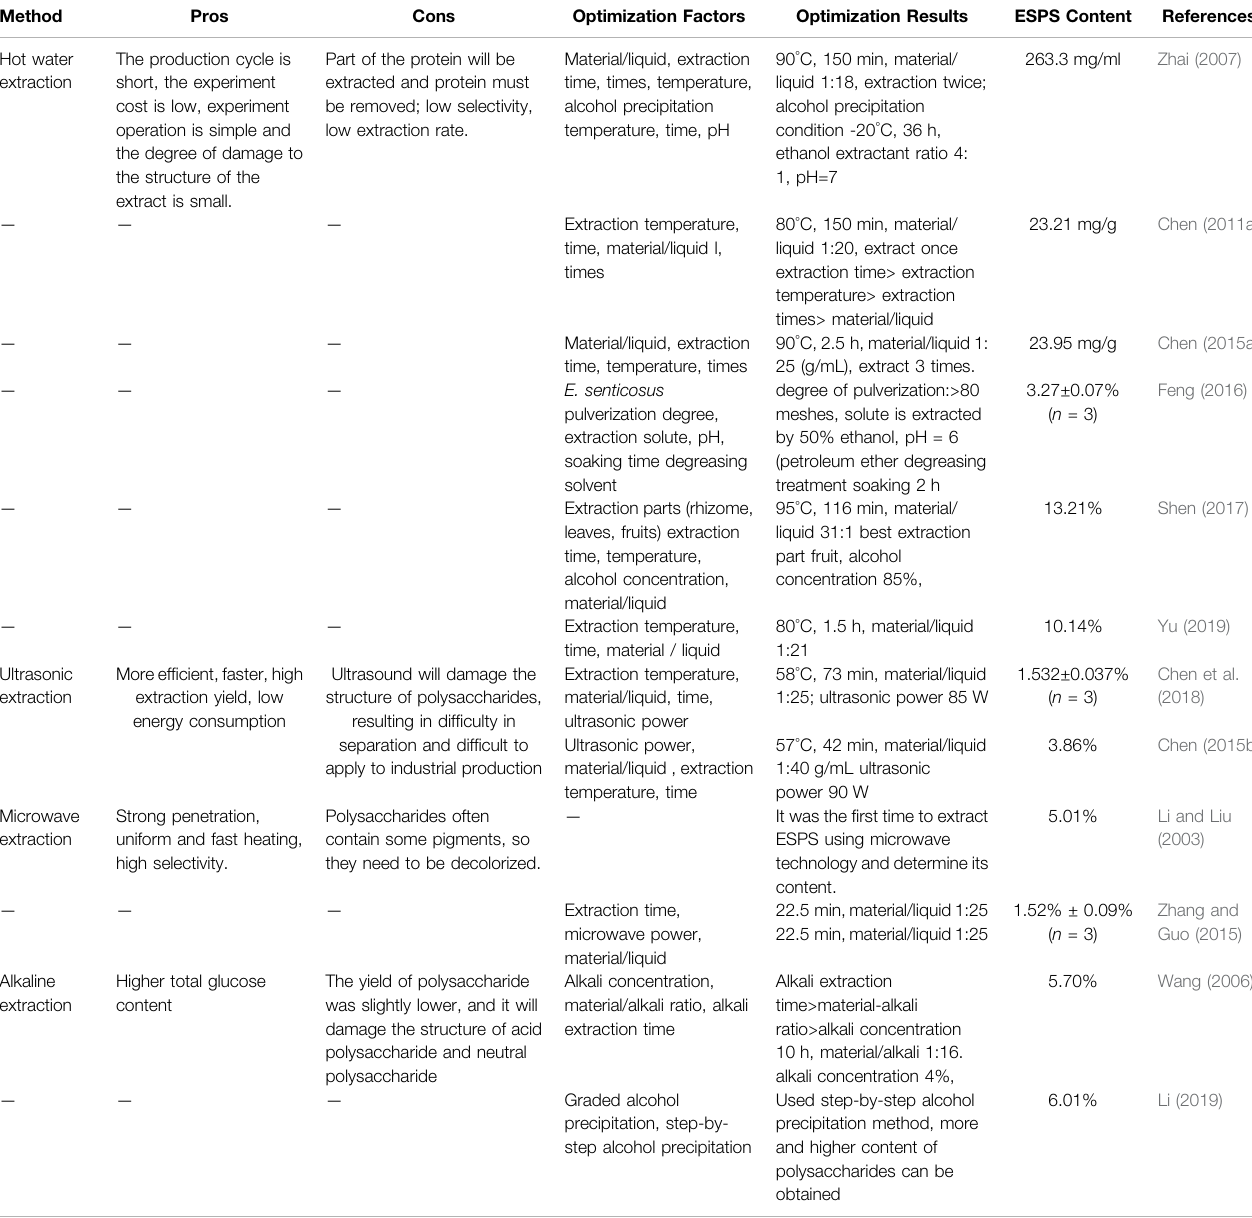
TABLE 1 | Summary of the extraction process of ESPS. Method Pros Cons Optimization